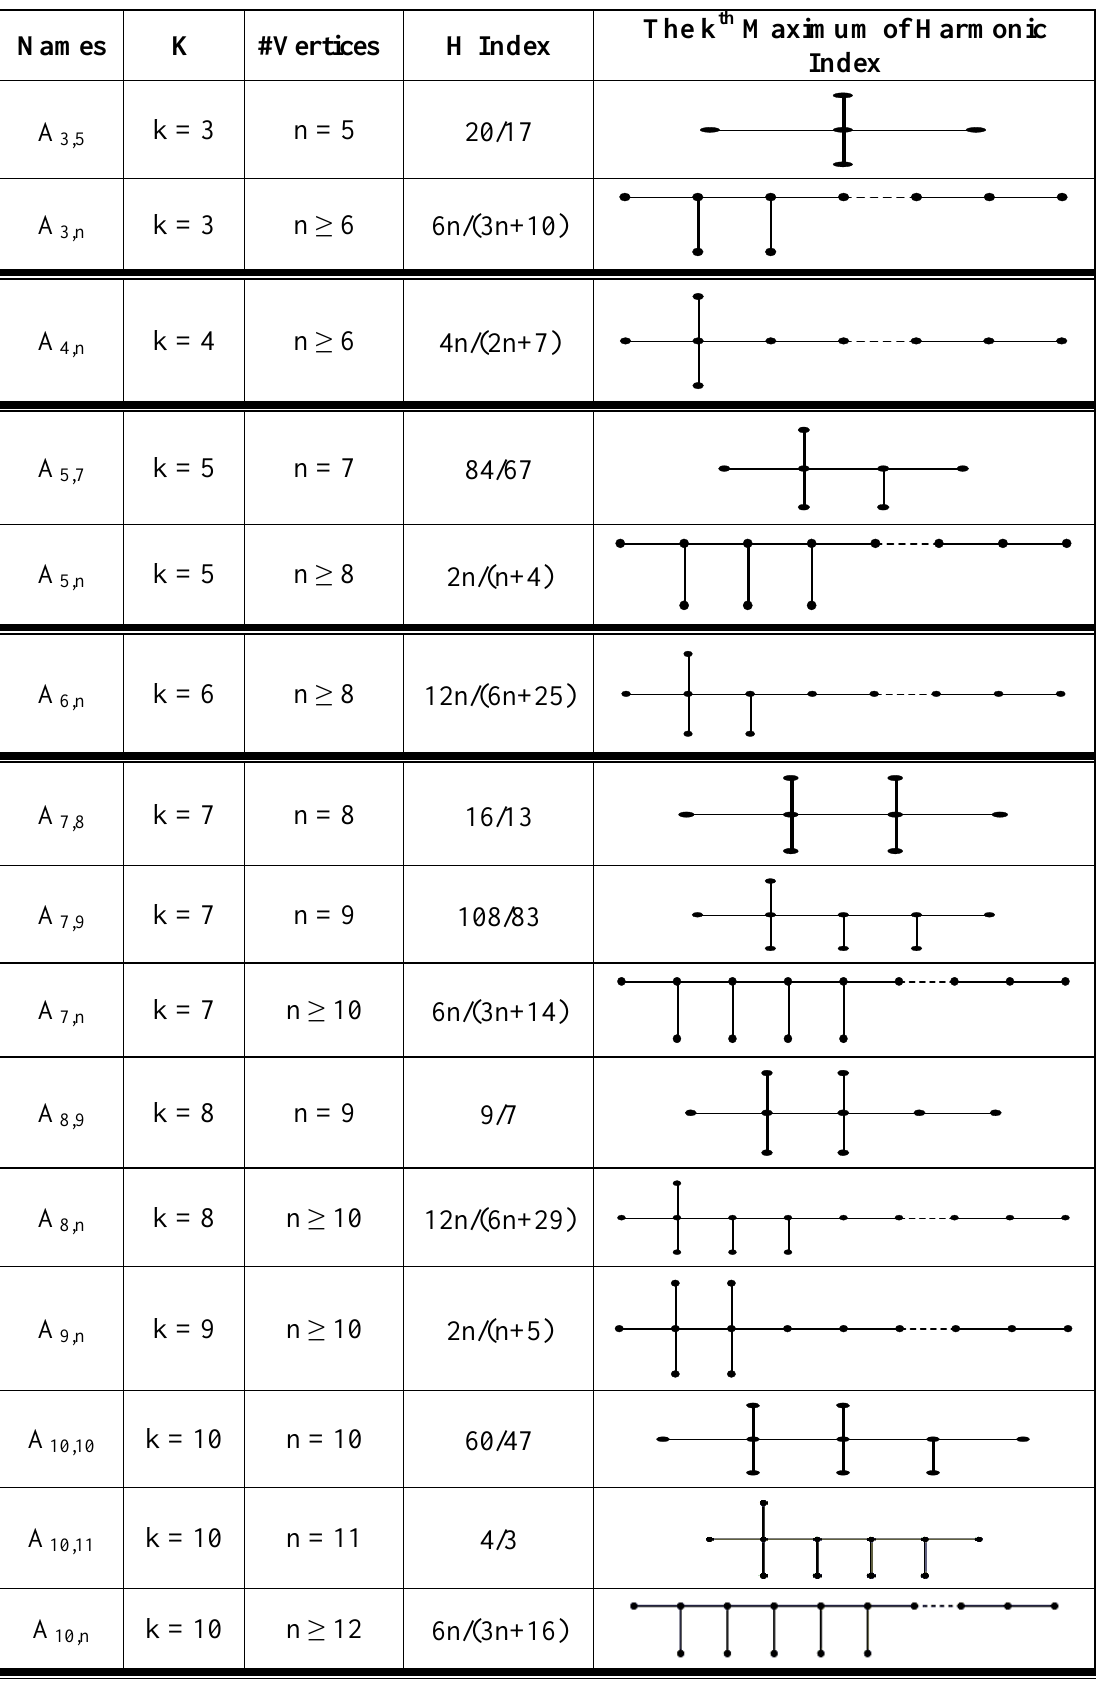
Table 3. The k th Maximum of Harmonic Index of Chemical Trees, 3 £ k £